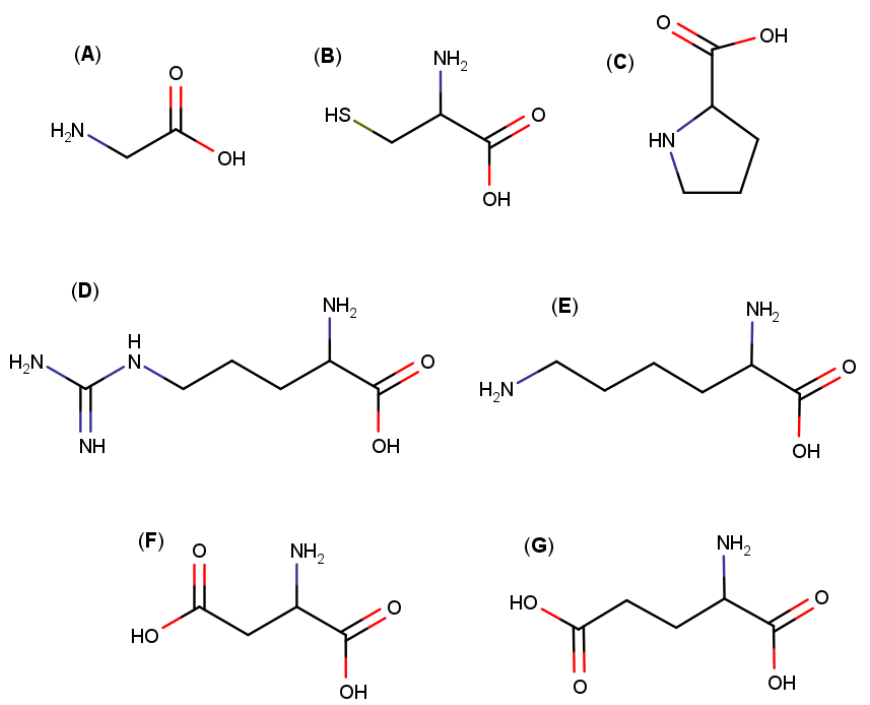
Figure 2. Molecular structures of: ( A ) glycine, ( B ) cysteine, ( C ) proline, ( D ) arginine, ( E ) lysine, ( F ) aspartic acid and ( G ) glutamic acid.